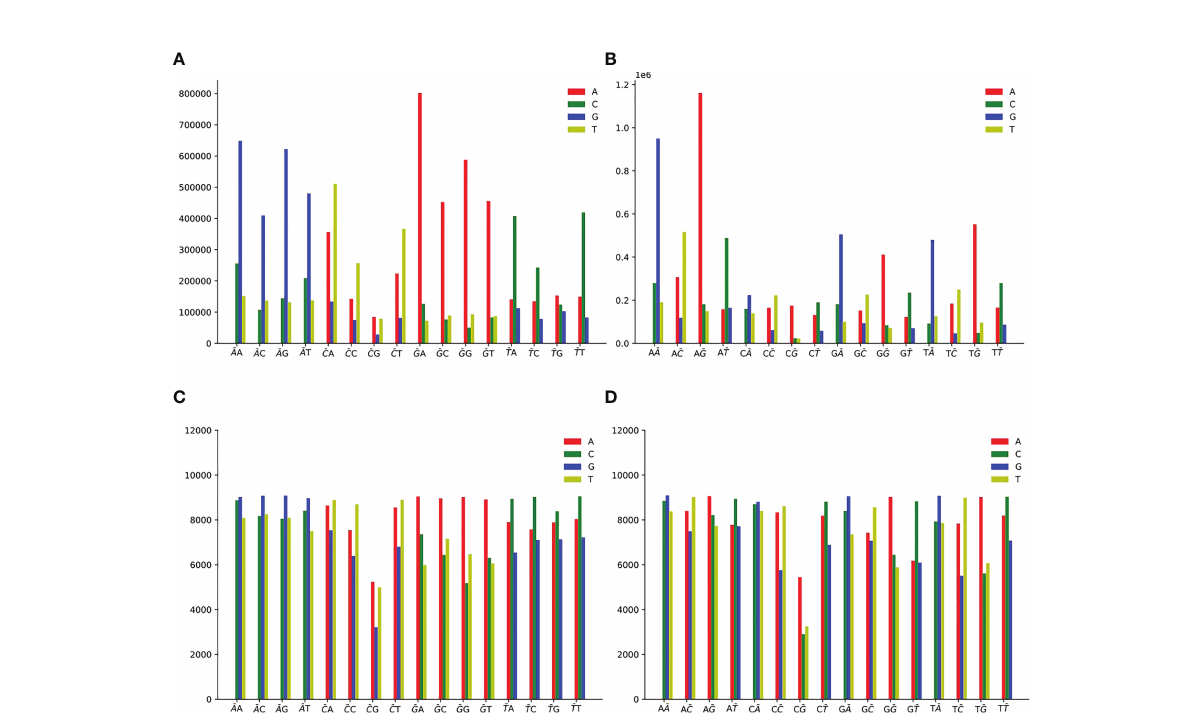
FIGURE 5 Single mutation counts of 2-mers. There are 16 dinucleotide sequences: AA, AC, AG, AT, CA, CC, CG, CT, GA, GC, GG, GT, TA, TC, TG, TT. (A) Single non-unique mutation counts at the fi rst position of 2-mers. (B) Single non-unique mutation counts at the second position of 2-mers. (C) Single unique mutation counts at the fi rst position of 2-mers. (D) Single unique mutation counts at the second position of